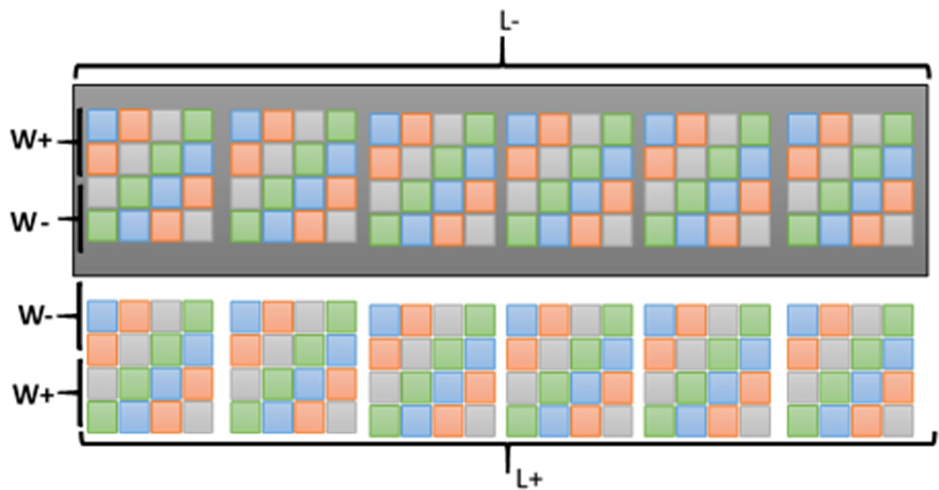
Figure 2. Seedling arrangement in a split-plot experiment with two factors (light and water availabil- ity) of two levels each (light: L+ and L − ; water: W+ and W − ), and treatments replicated in 12 blocks (with 16 seedlings each, 4 seedlings per species). Six blocks were under L − (upper blocks, shaded in gray) and other six blocks were under L+ light conditions (lower blocks). Half of the seedlings in each block within a light condition (ie, 6 seedlings, 2 seedlings per species) were submitted to a different water treatment (W+ or W − ). Pinus pinea in blue, Juniperus thurifera in red, Quercus faginea in gray and Quercus ilex in green.